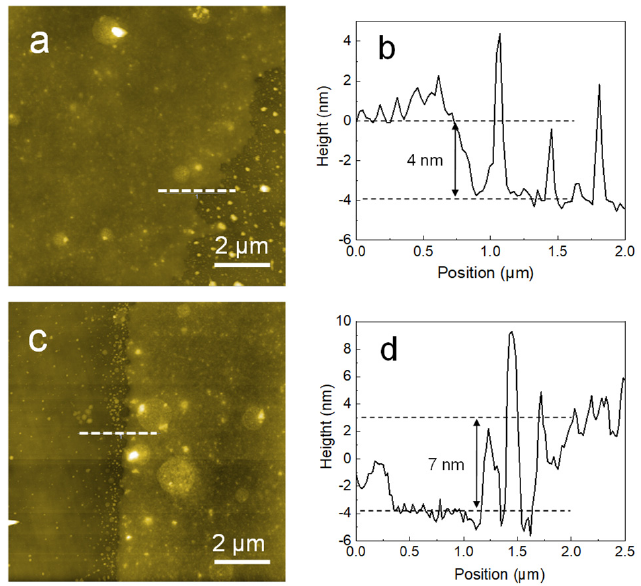
Figure 2. Typical atomic force microscopy (AFM) images ( a , c ) and corresponding cross section curves ( b , d ) of Cu 3 P nanofilm. The dark area is due to the silicon substrate. Scale bars in AFM images represent 2 μ m.